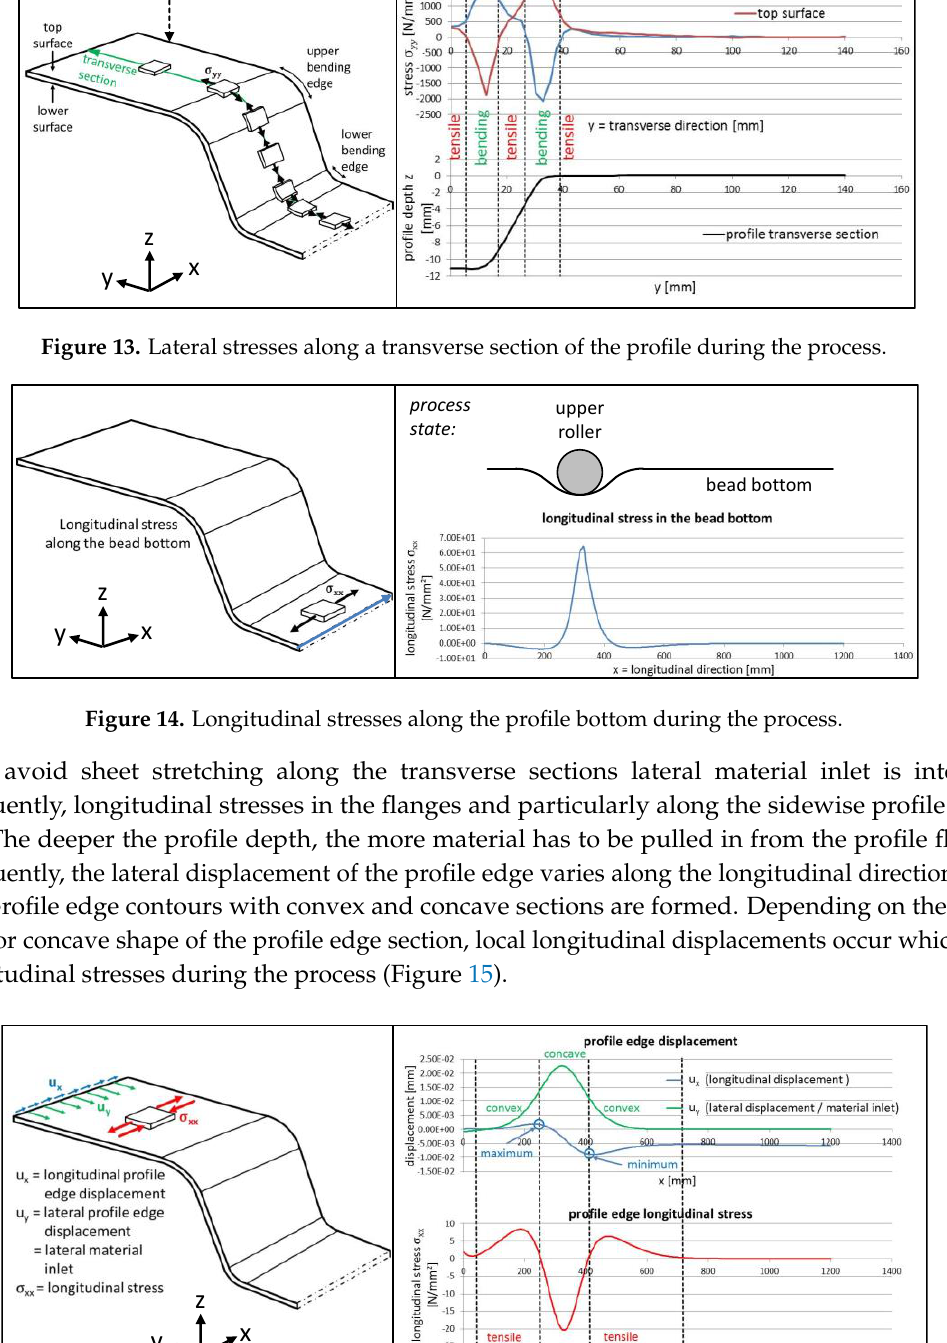
Figure 16. Displacement paths of the concave/convex shaped profile edge.